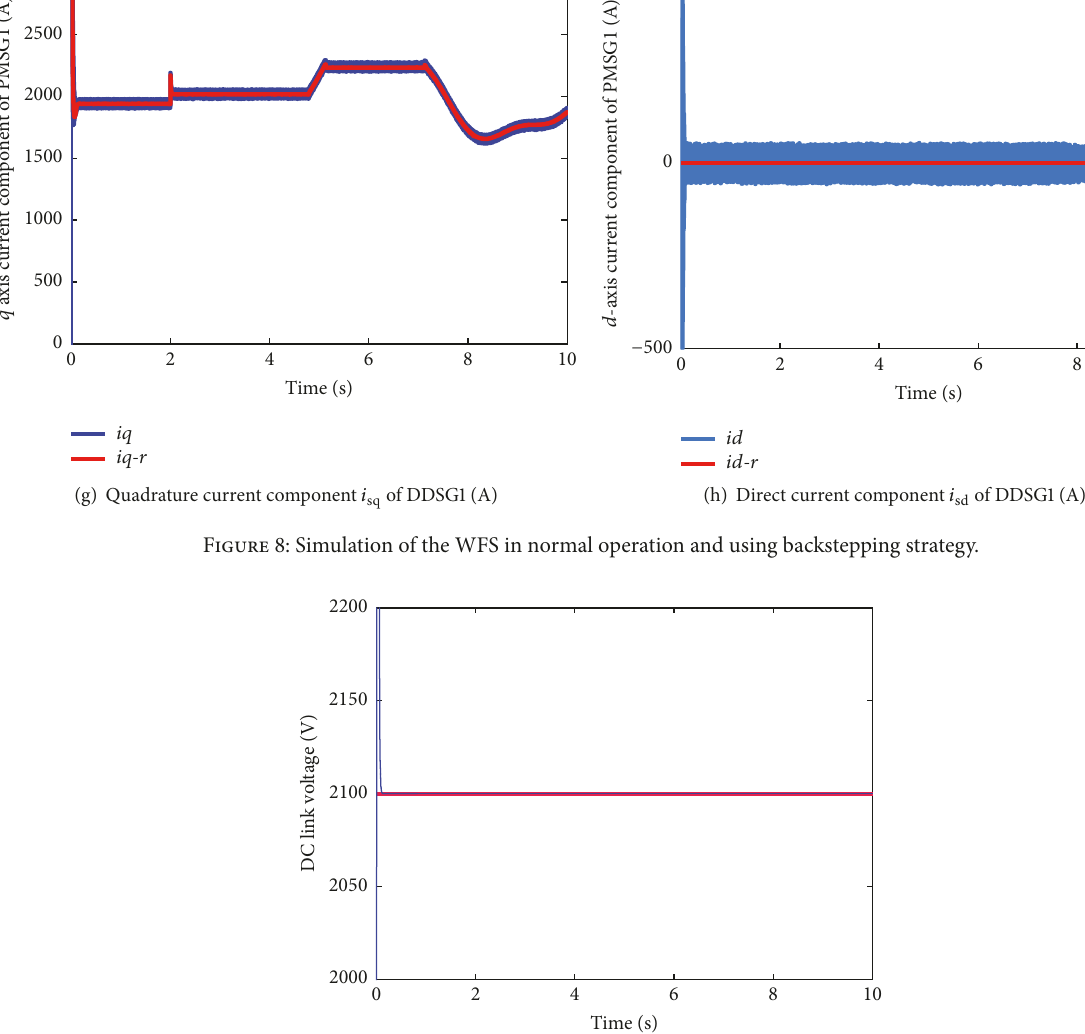
Figure 9: dc-link voltage (V).